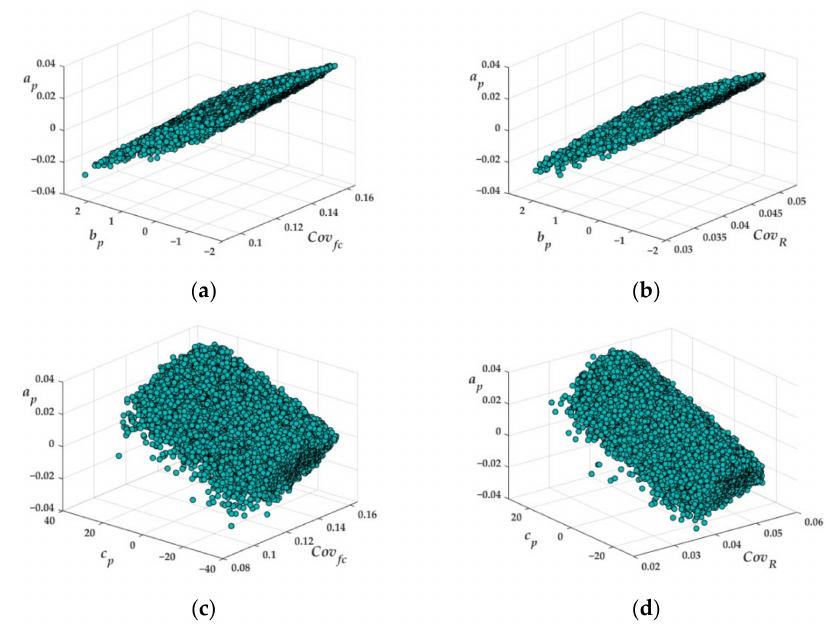
Figure 10. Relationship between the coefficients of the calibrated polynomial empirical laws a p , b p , c p and the coefficients of variation for m = 18: ( a ) plot a p vs. b p and the coefficient of variation of the concrete strength Cov fc ; ( b ) plot a p vs. b p and the coefficient of variation of the rebound index Cov R ; ( c ) plot a p vs. c p and the coefficient of variation of the concrete strength Cov fc ; ( d ) plot a p vs. c p and the coefficient of variation of the rebound index Cov R